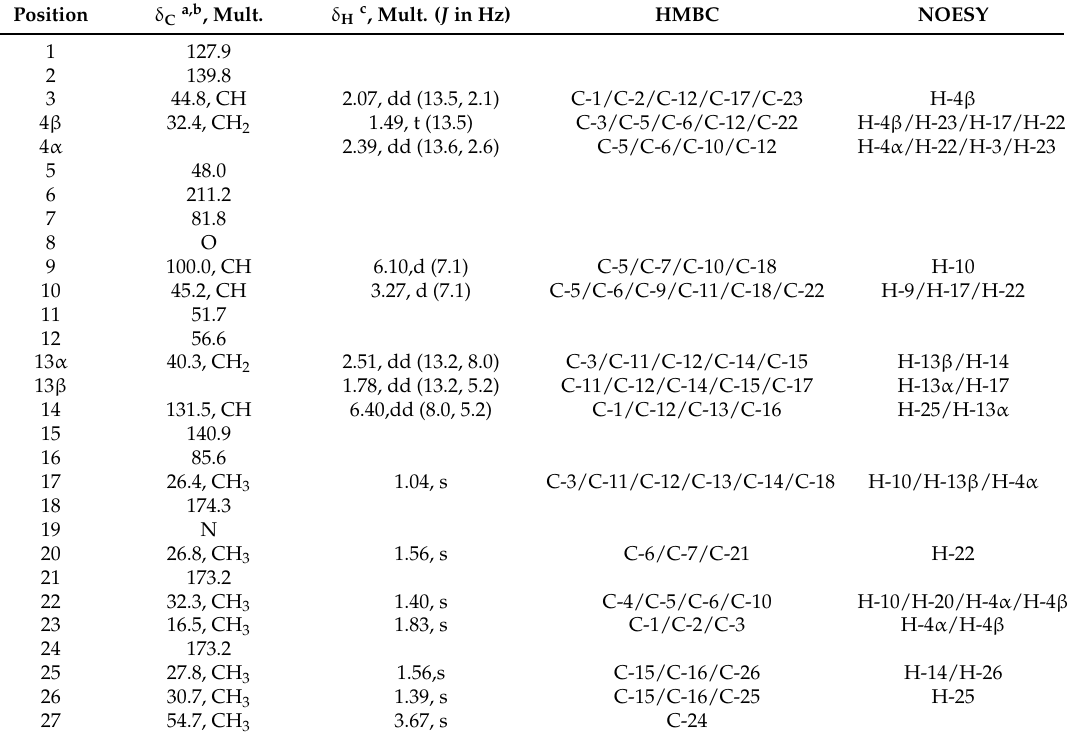
Table 1. NMR data for compound 1 (600 MHz, CD 3 OD).